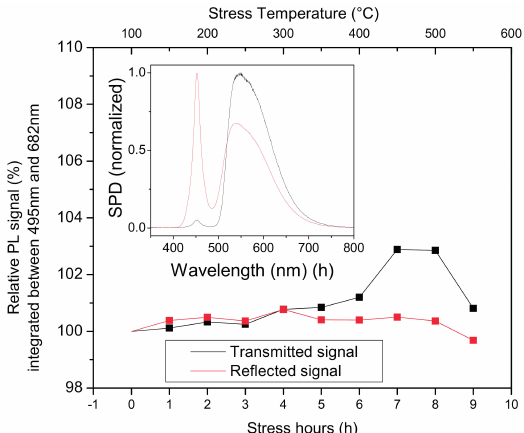
Figure 6. Photoluminescence signal of the YAG:Ce phosphor during the step–stress analysis. Inset: normalized spectrum of the transmitted and reflected signal.